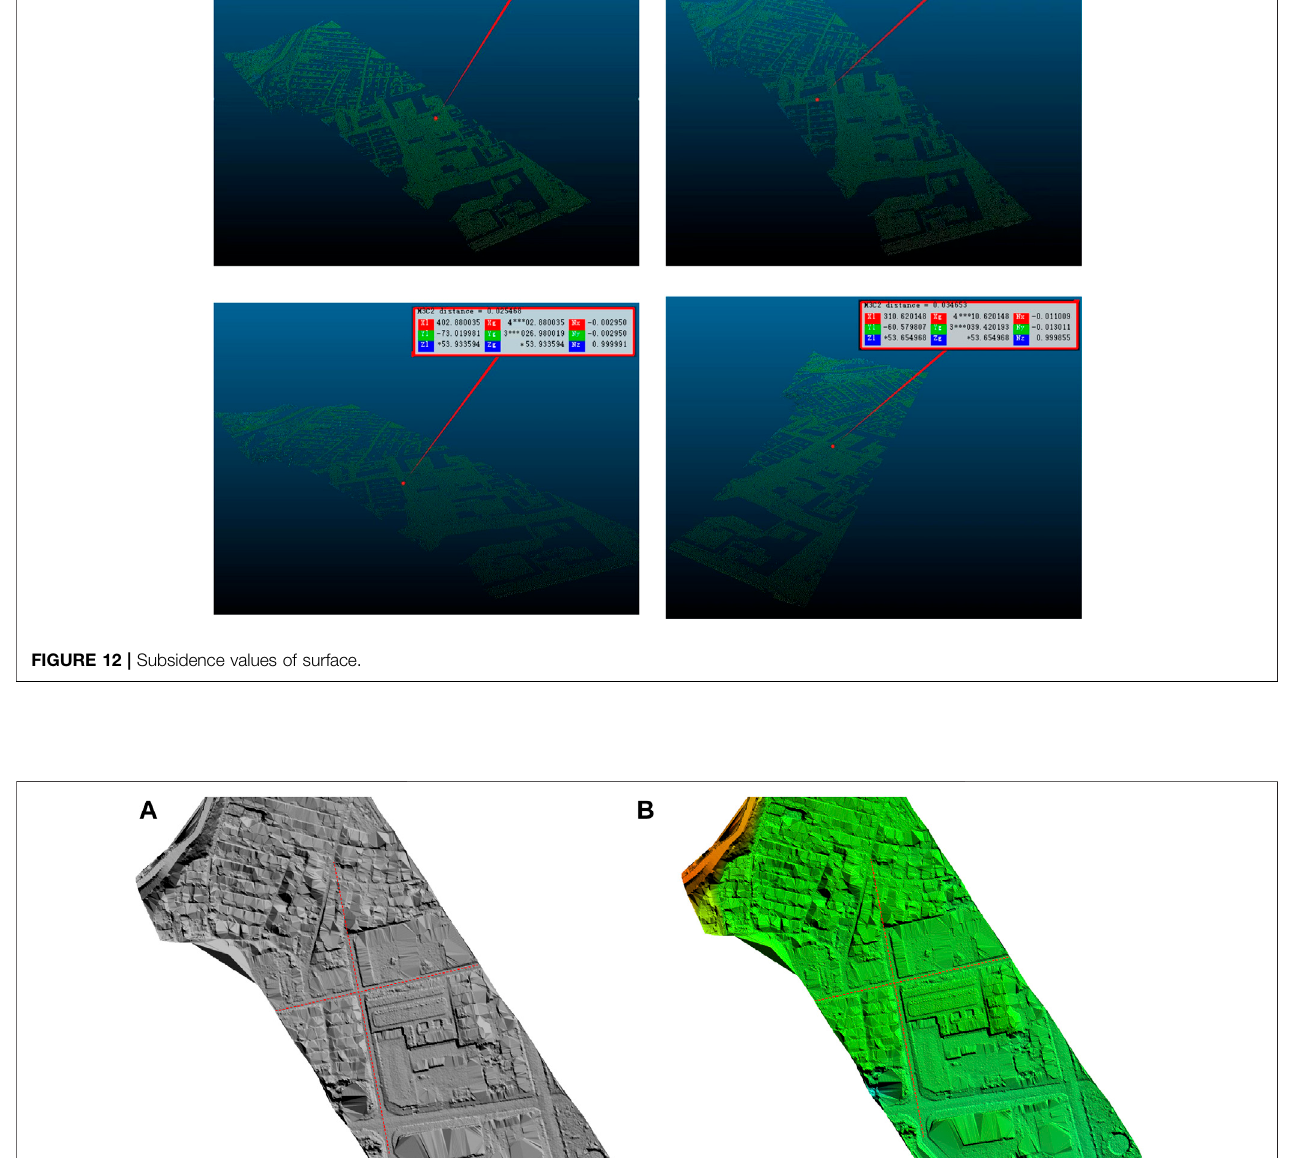
Frontiers in Earth Science |